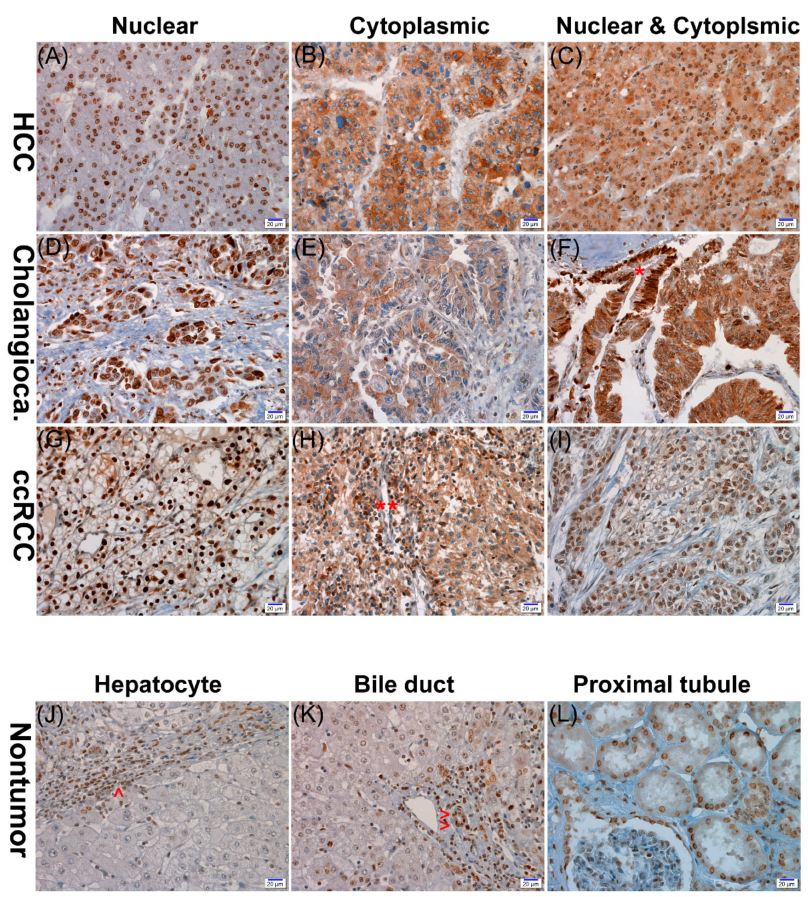
Figure 1. Representative photographs of APEX1 immunohistochemical staining in hepatocellular carcinoma (HCC) ( A – C ), cholangiocarcinoma (Cholangioca) ( D – F ), and clear cell renal cell carcinoma (ccRCC) ( G – I ). The three cancers show nuclear, cytoplasmic, or nuclear and cytoplasmic expression of APEX1. The nontumor proliferative biliary epithelium (*) expresses nuclear staining, while the cholangiocarcinoma cells show both nuclear and cytoplasmic expression ( F ). Inflammatory cells (**) exhibit cytoplasmic staining ( H ). No APEX1 expression in nontumor hepatocytes in contrast to the high nuclear expression in inflammatory cells (ˆ) ( J ). Positive nuclear expression in nontumor bile duct epithelial cells (ˆˆ) ( K ). Positive nuclear expression in proximal convoluted tubular epithelial cells ( L ) (scale bar = 20 µ